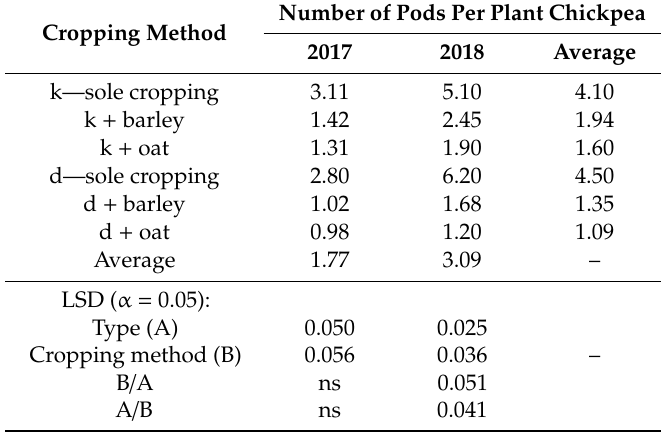
Table 3. Number of pods per chickpea plant, depending on cropping method and type (k—kabuli;